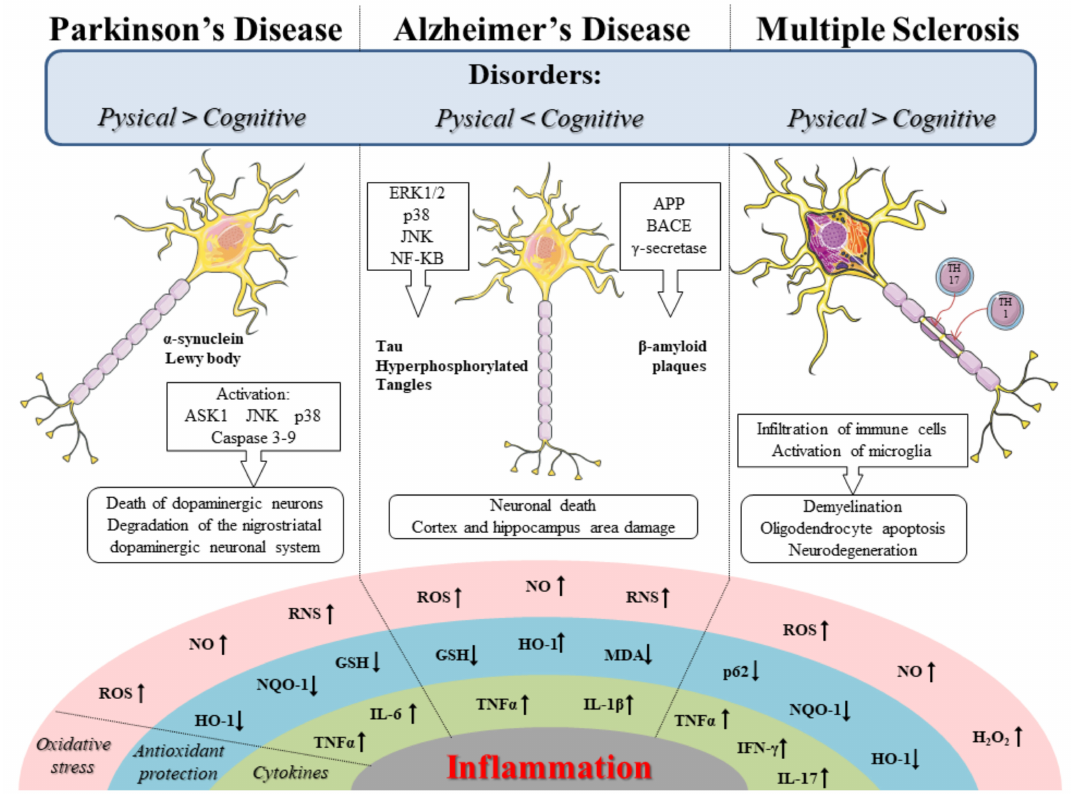
Figure 1. Schematic representation of the oxidative stress and inflammation pathways in Parkinson’s disease (PD), Alzheimer’s disease (AD), and multiple sclerosis (MS). The figure was made taking the images from Servier Medical Art (available at http: // smart.servier.com / ), licensed under a Creative Commons Attribution 3.0 Unported License (https: // creativecommons.org / licenses / by / 3.0 / ). ROS, Reactive oxygen species; NO, Nitric oxide; RNS, Reactive nitrogen species; HO-1, Heme oxygenase 1; NQO-1, Nicotinamide adenine dinucleotide phosphate quinone oxidoreductase 1; GSH, Glutathione; MDA malondialdehyde; p62; H 2 O 2, Hydrogen peroxide; TNF- α , Tumor necrosis factor- α ; IL-6, Interleukin-6; IL-1 β , Interleukin-1 β ; IFN- γ , Interferon- γ ; ERK, Extracellular signal-related kinase; p38; JNK, c-Jun N-terminal kinase; NF- κ B, Nuclear factor kappa-B; ASK1, Apoptosis signal-regulating kinase 1; APP, Amyloid precursor protein; A β , Beta-amyloid; BACE, β